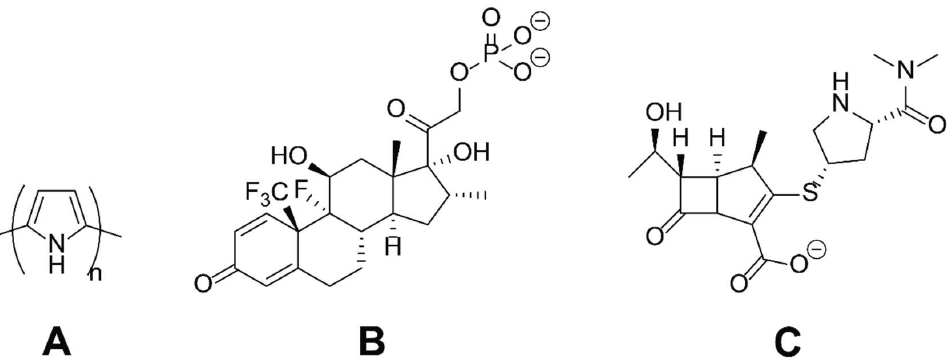
Figure 1. The chemical structures of the substances studied herein: ( A ) Polypyrrole (PPY); ( B ) dexamethasone phosphate (DMP); ( C ) meropenem